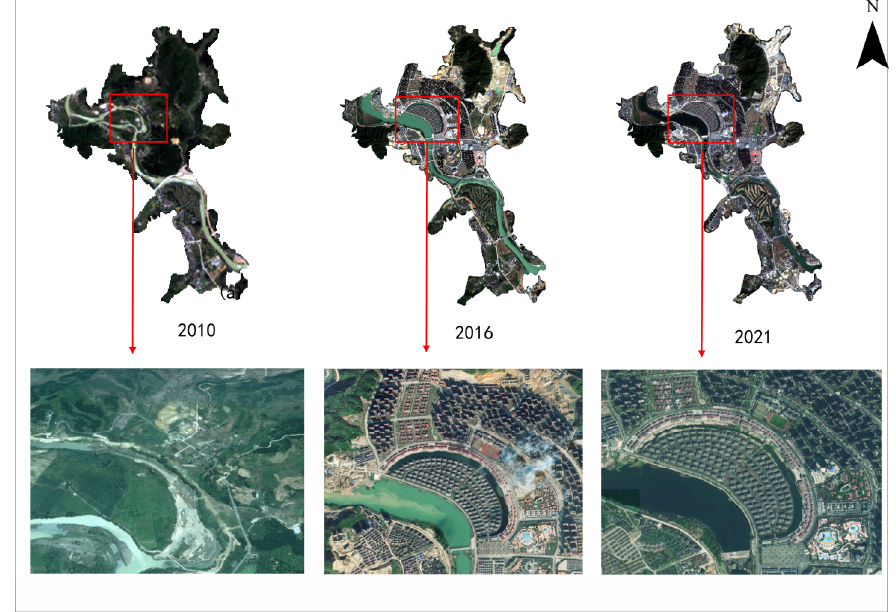
Figure 8. Specific urban construction changes in Gui ’an during the two-stages.